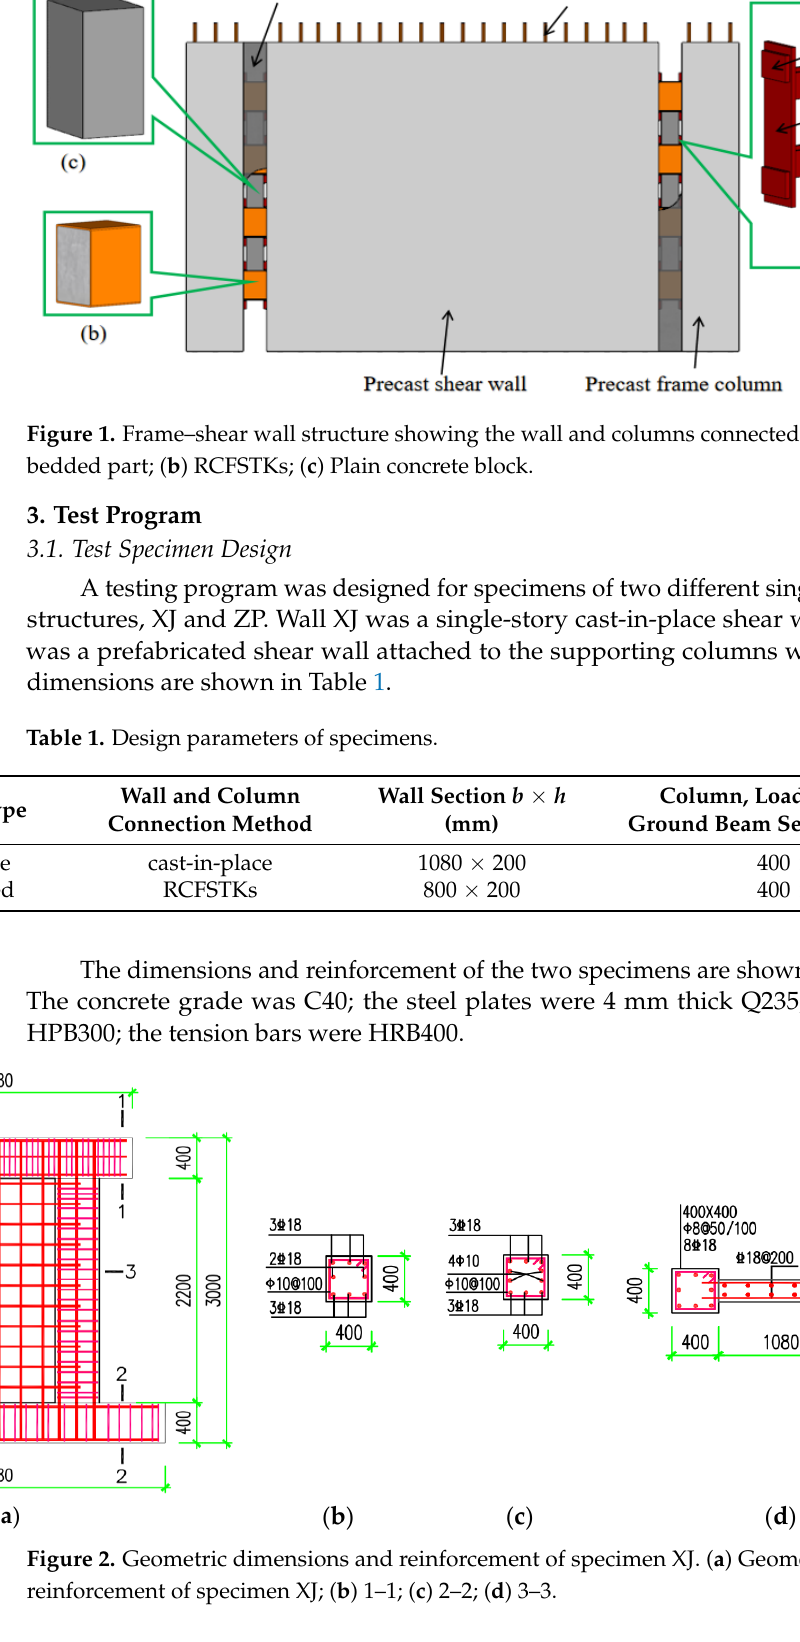
Figure 2. Geometric dimensions and reinforcement of specimen XJ. ( a ) Geometric dimensions and reinforcement of specimen XJ; ( b ) 1 – 1; ( c ) 2 – 2; ( d ) 3 – 3.